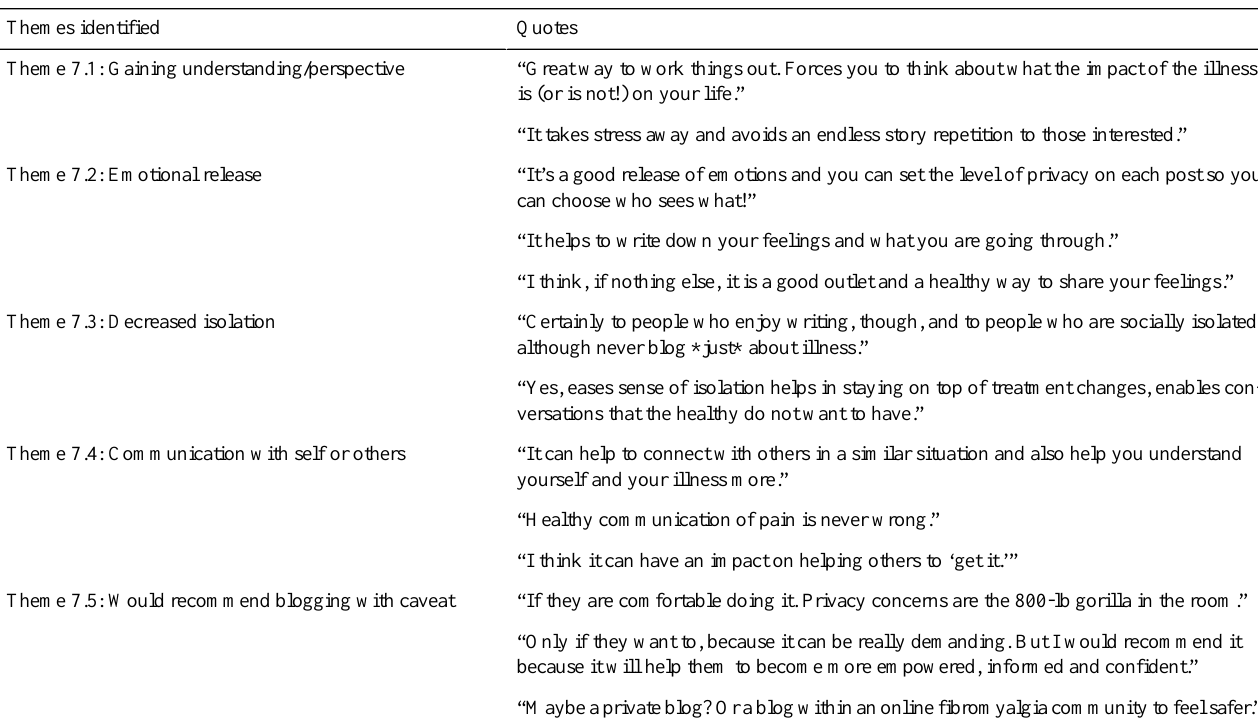
Table 9. Reasons of recommending